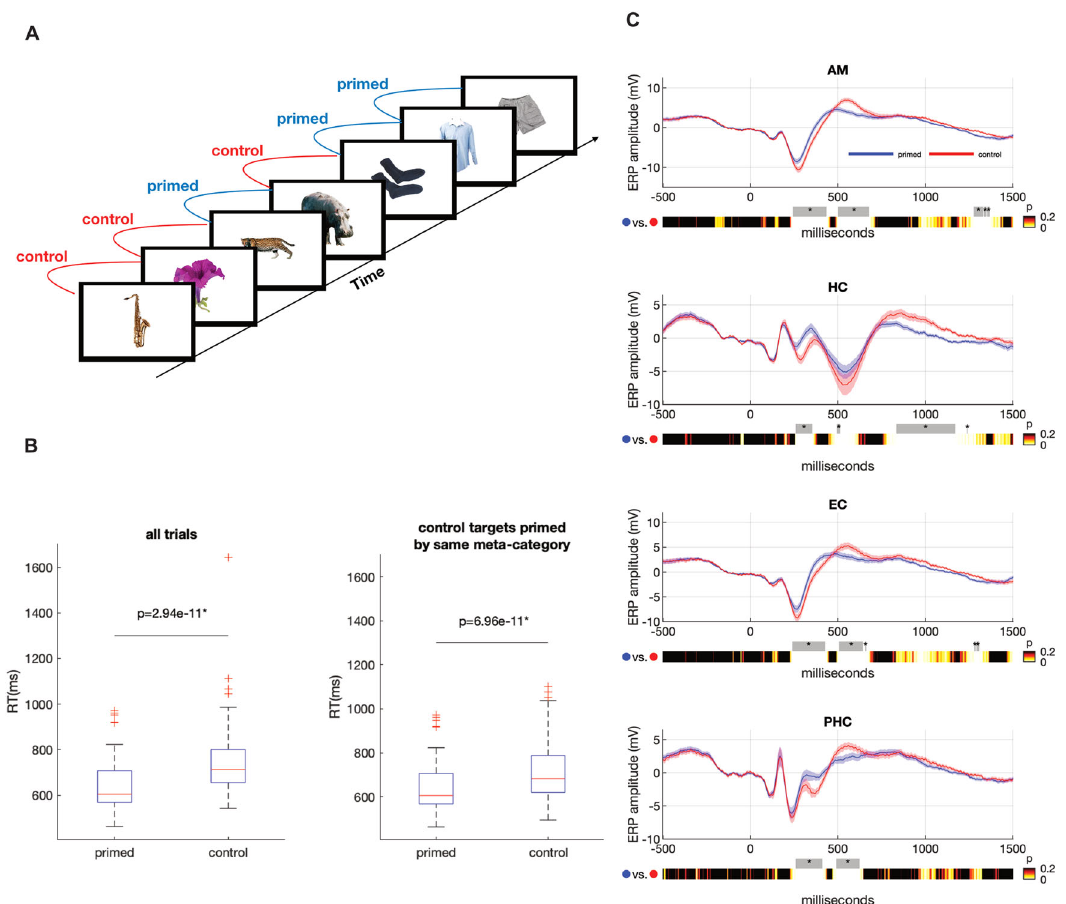
Fig. 1 | Design, ERPs, and behavioral data. A Participants performed a manmade vs.naturaldecisiononimagespresentedinasequencethatwasarrangedsuchthat half of the images were preceded by the same/different category (primed/control condition). B Behavioral priming is observed in signi fi cant differences in mean reaction time differences (RT) between primed and control targets. Sample size n =59 sessions. P -values are derived from an uncorrected Wilcoxon Signed Ranks test. The left plot includes all trials ( p =2.94×10 − 11 , Z =4), whereas the right plot only includes control targets that were preceded by prime stimuli affording the same behavioral response ( p =6.96×10 − 11 , Z =21; manmade/natural